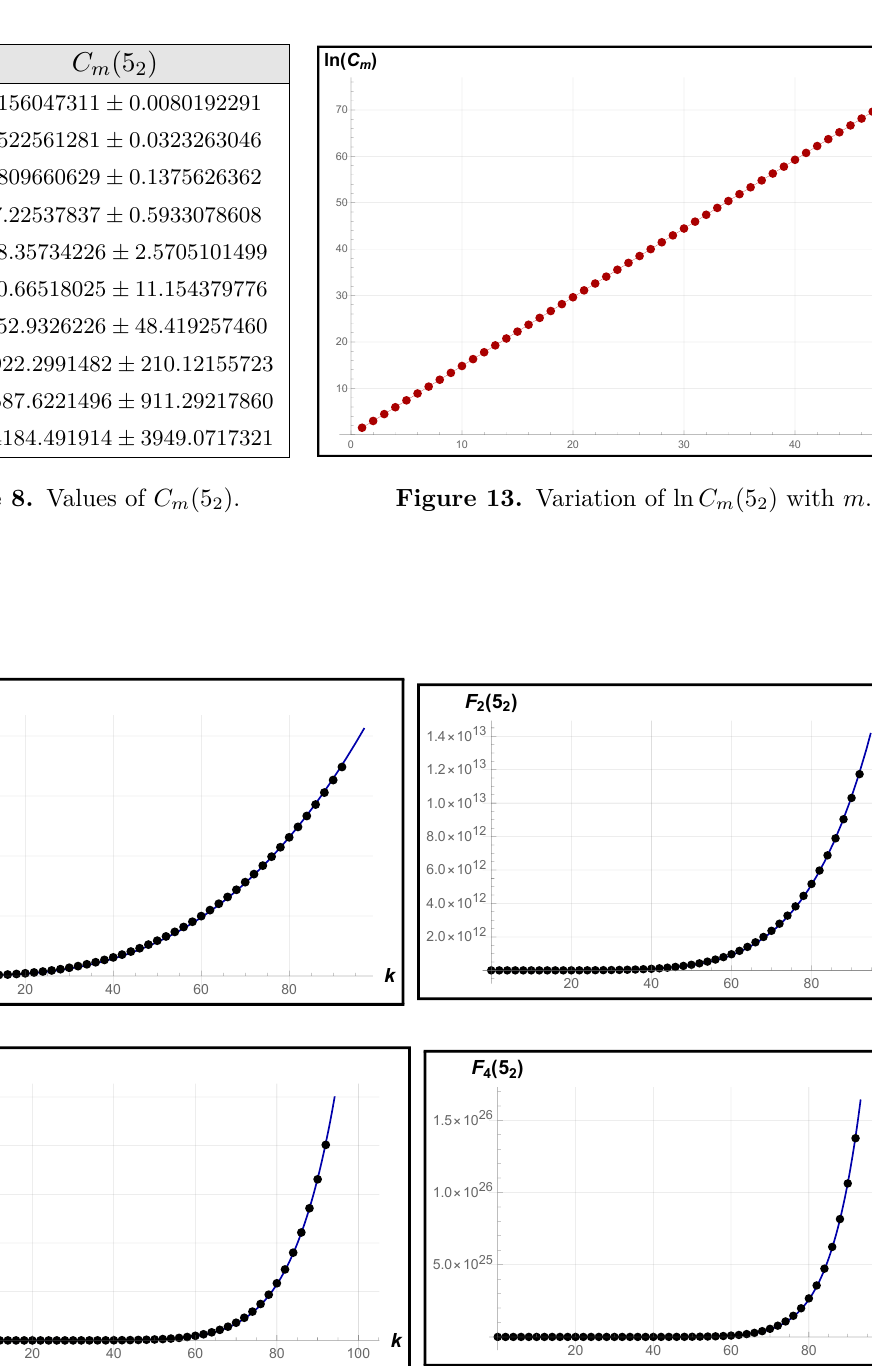
Figure 14. The variation of the function F m with k for 5 2 knot. The solid line denotes the function C m k 3 m with values of C m given in table 8. The • indicates the numerical values of F m obtained from explicit